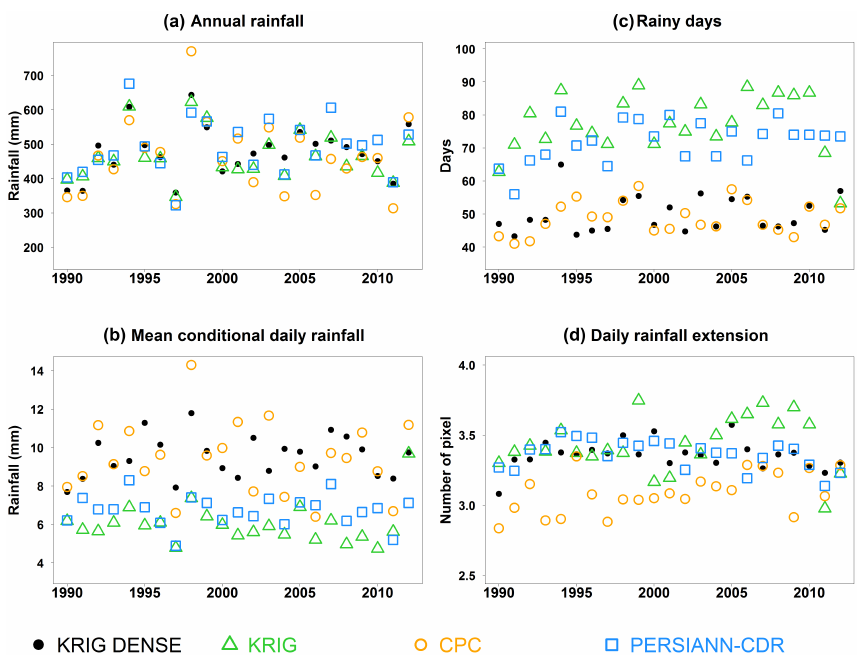
Figure A1. Annual (JJAS) series of rainfall characteristics between 1990 and 2012 computed for the reference (KRIG-DENCE, black dots) and the three tested products: KRIG (open green triangle), CPC (open orange circle) and PERSIANN-CDR (open blue square). (a) mean annual rainfall amount series, (b) annual number of rainy day, (c) mean conditional daily rainfall series and (d) mean of rain extension over the studied area (in